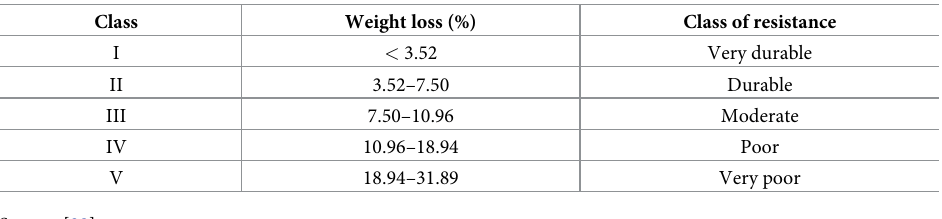
Table 2. Classification of the resistance class to termite